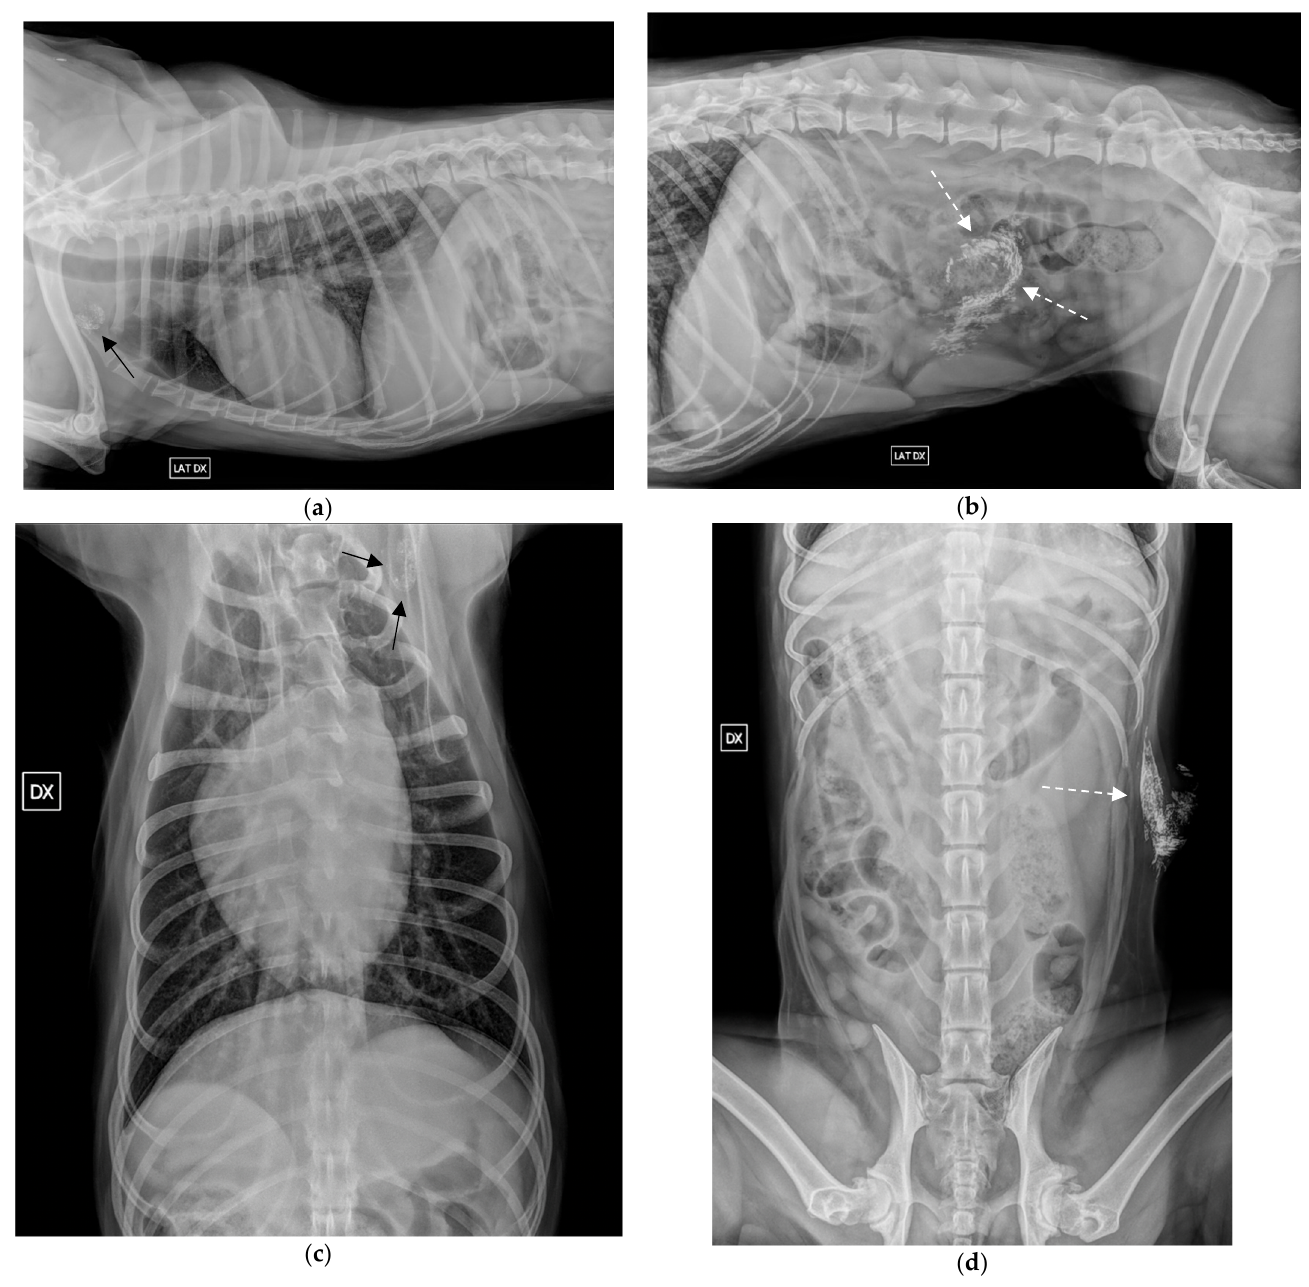
Figure 1. Radiographic indirect lymphangiography 24 h post-Lipiodol of a MCT in the left abdominal wall. ( a , c ) right lateral and VD view of the thorax. The left axillary SLN is highlighted by the black arrow; ( b , d ) Right lateral and VD view of the abdomen. The Lipiodol was injected at the periphery of the tumour in the left abdominal wall (white dashed arrow).